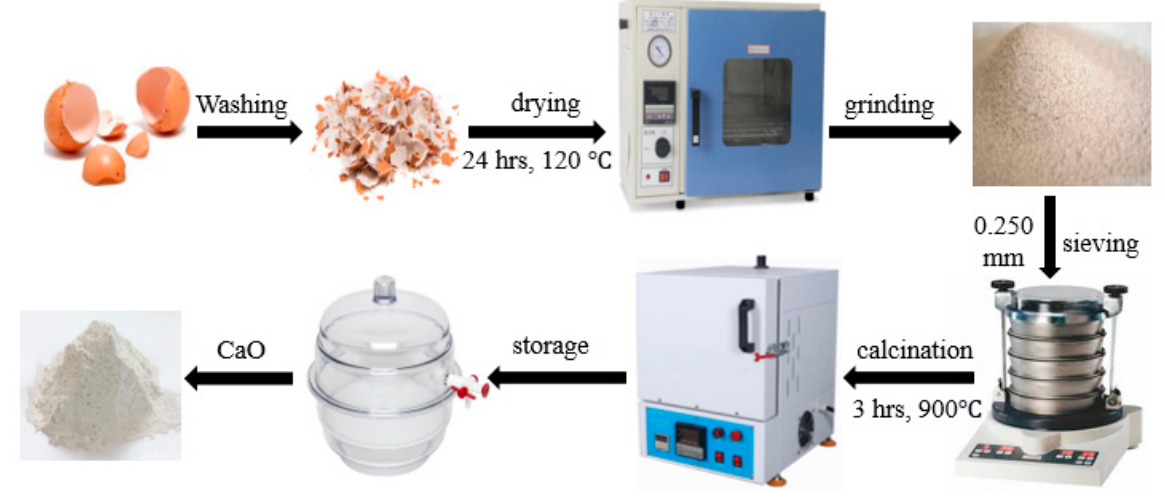
Figure 15. Schematic diagram of CaO synthesis.